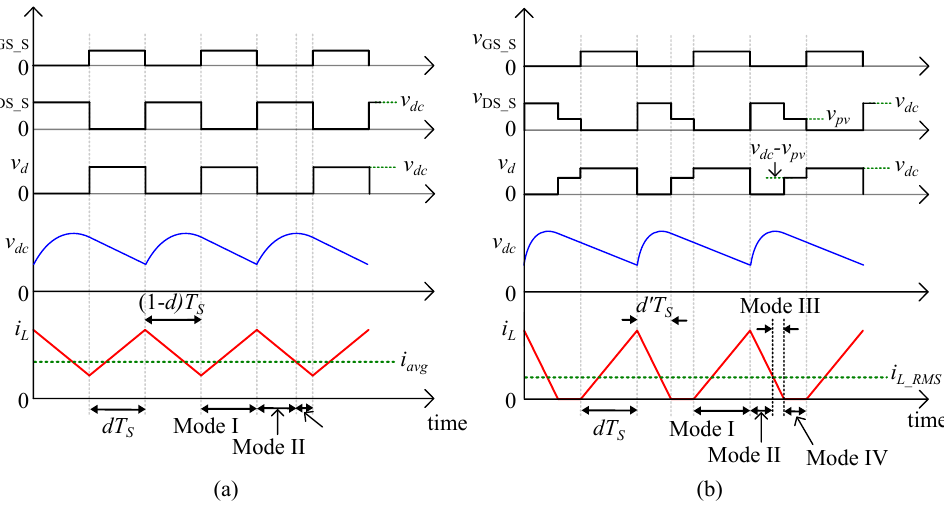
Figure 9. Theoretical waveformsof boost converter: ( a ) CCM, and ( b ) DCM. Mode